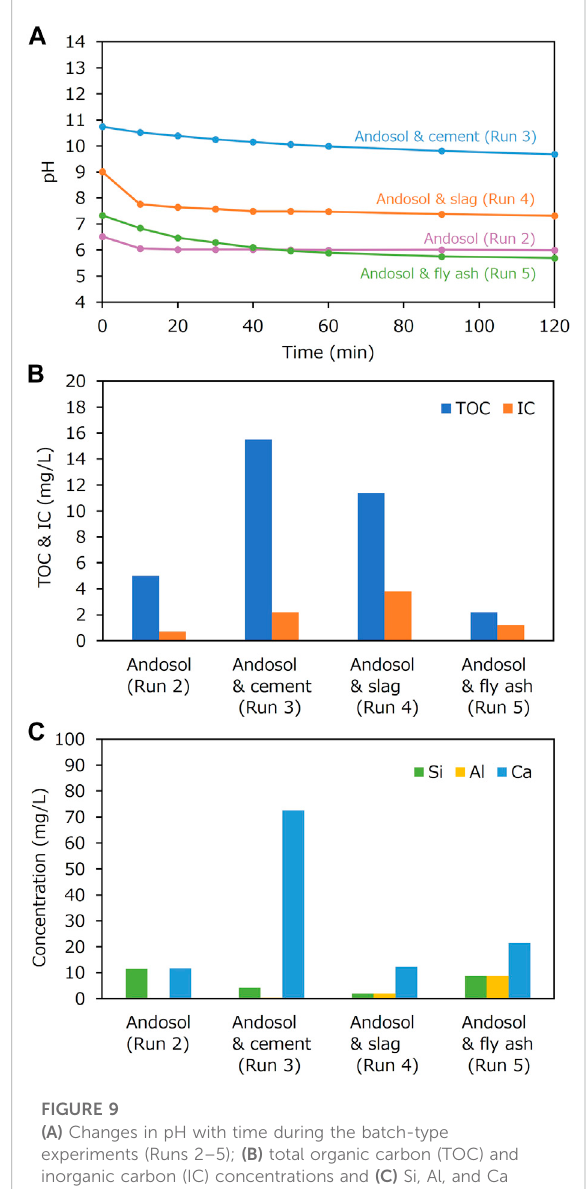
FIGURE 9 (A) Changes in pH with time during the batch-type experiments (Runs 2 – 5); (B) total organic carbon (TOC) and inorganic carbon (IC) concentrations and (C) Si, Al, and Ca concentrations in the liquid samples, after the